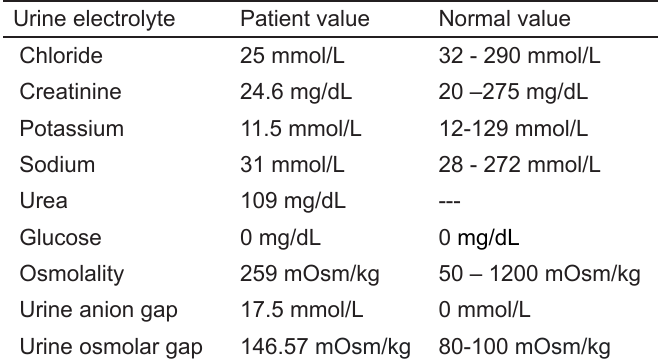
Table 2 . Urine electrolytes of a 19-year-old female with weakness. Urine